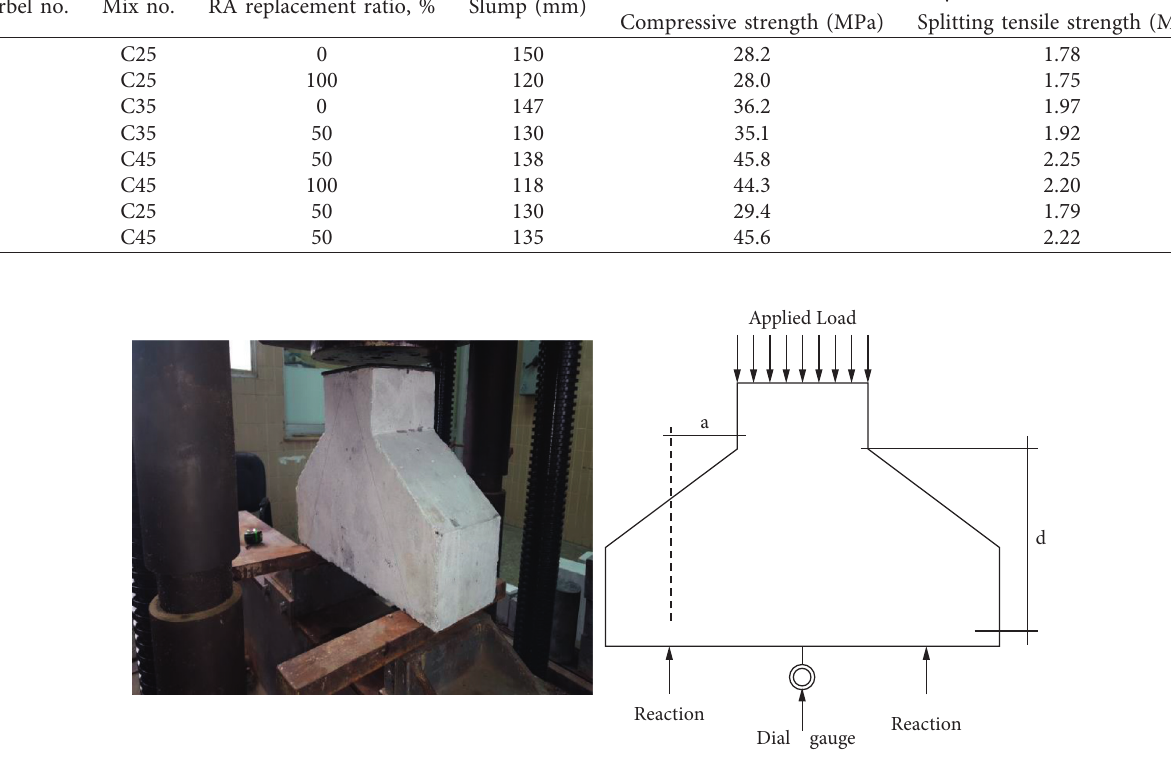
Figure 3: Loading arrangement of corbels.